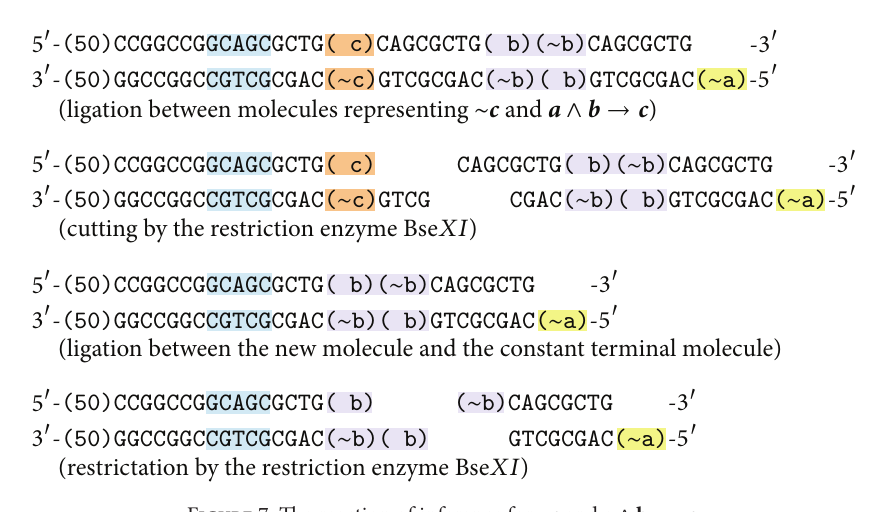
Figure 7: The reaction of inference for ∼ c and a ∧ b → c